Question: What caption would you write for this figure?
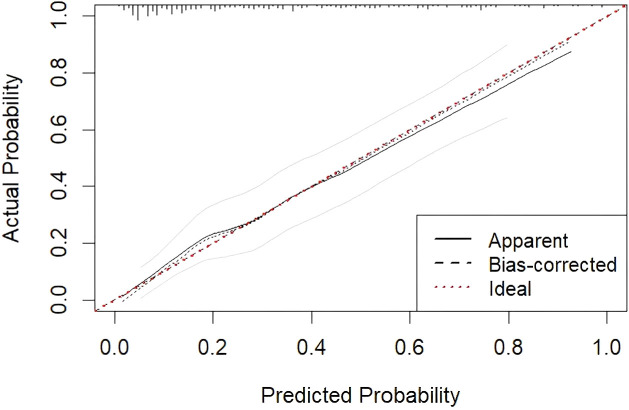
Answer: Calibration curve of the prediction model.